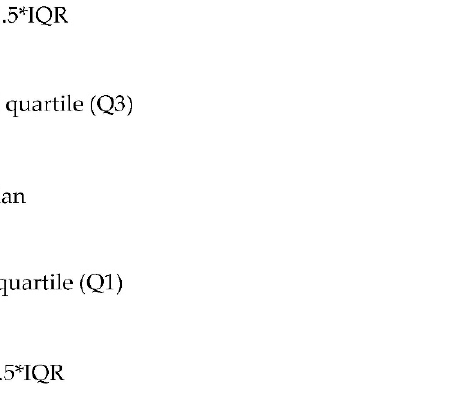
Figure 6. Explanation of the box plot structure elements (source: Sabat-Tomala et al. [52] modi- fied).